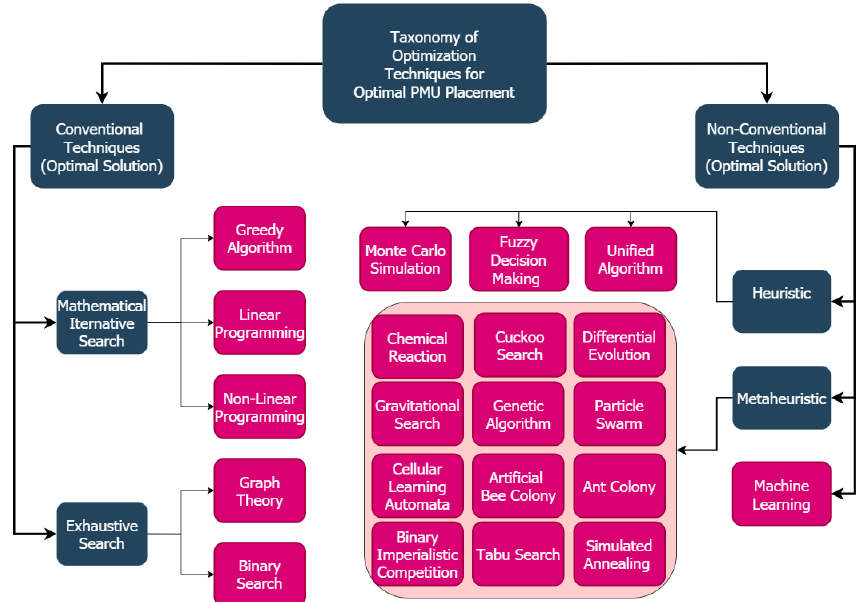
Figure 2. Taxonomy of optimization techniques used in optimal PMU